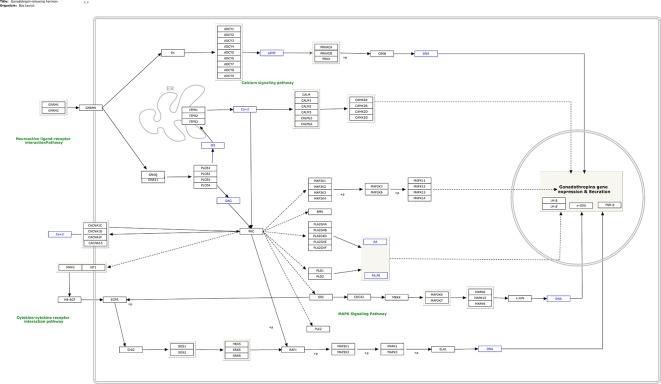
Gonadotropin-releasing hormone (GnRH) signaling (B. taurus) (based on Widmann et al., 2013) and available at https://www.wikipathways.org/instance/WP2901.